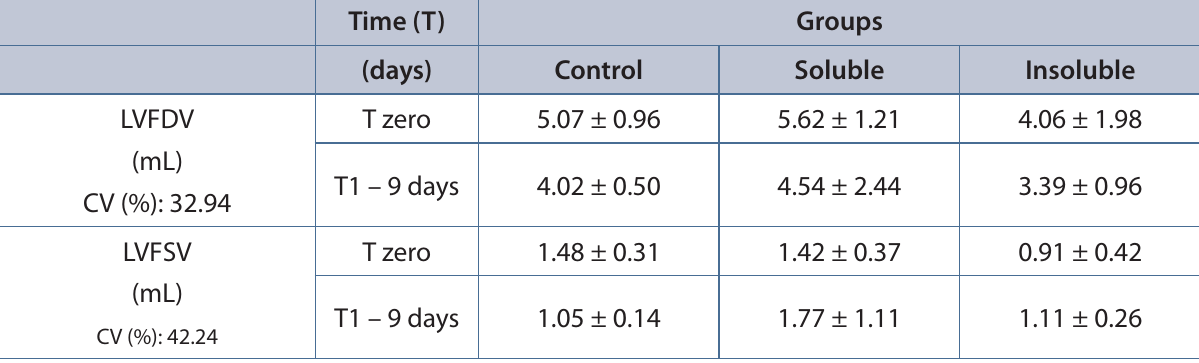
Table 10. Mean of the final diastolic volume* (LVFDV - mL) and final systolic volume* (LVFSV - mL) of left ventricle in rabbits submitted to gavage with ultra-pure water (CG), water-soluble A. rigida extract (SG) and water-insoluble A. rigida extract (IG) at different times